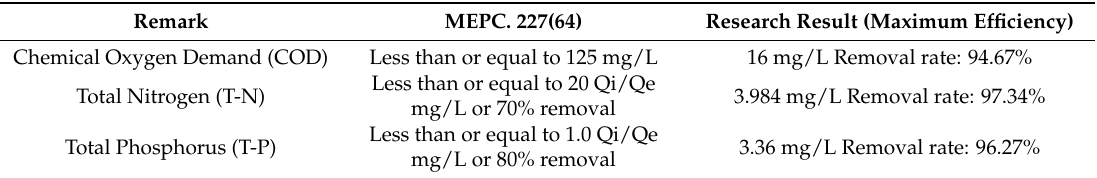
Table 3. MEPC 227(64) and Research Result